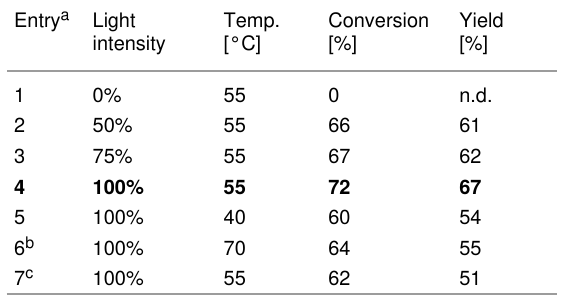
Table 1: Optimization of temperature and light intensity for the cou- pling of 4-iodobenzotrifluoride and sodium p -toluenesulfinate. Entry a Light intensity